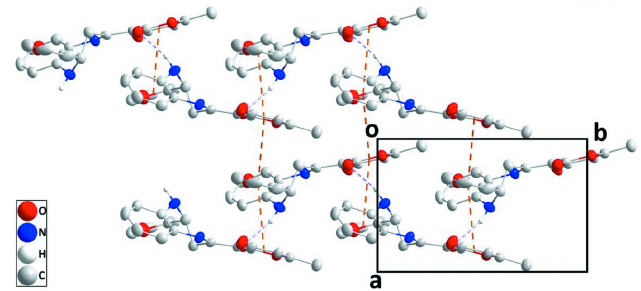
Figure 2 Portions of two chains viewed along the c axis direction with N—H (cid:3)(cid:3)(cid:3) O